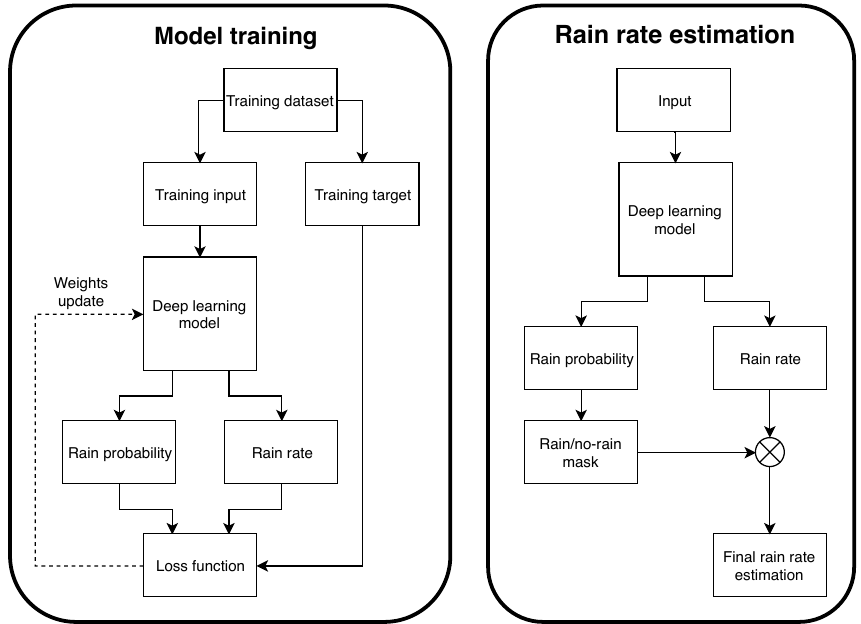
Figure 2. Flowchart for the training phase of the model ( left ) and its use to estimate precipitation rate after training ( right